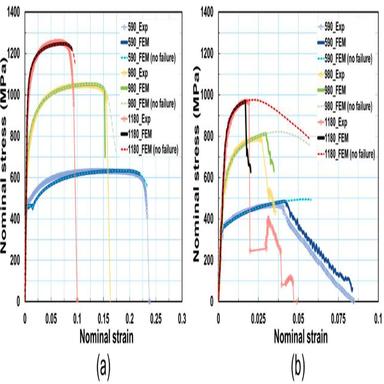
Analysis results of BM tensile tests for (a) JIS13B and (b) hole-notched specimen.